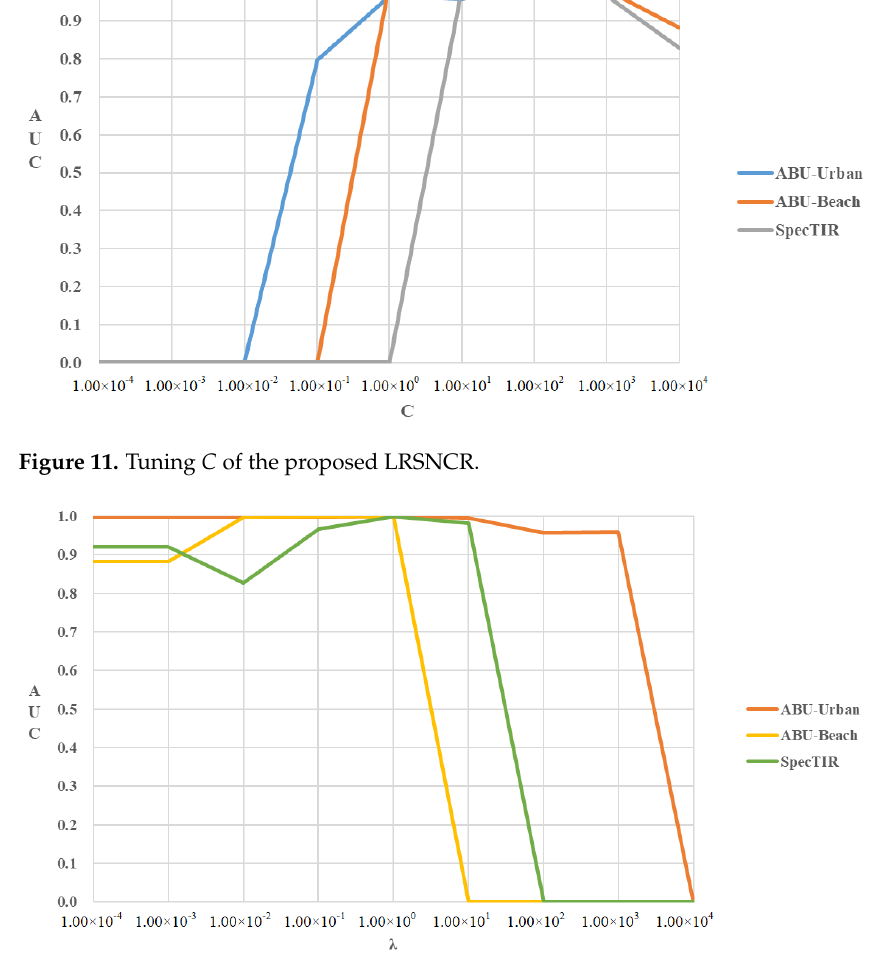
Figure 12. Tuning λ of the proposed